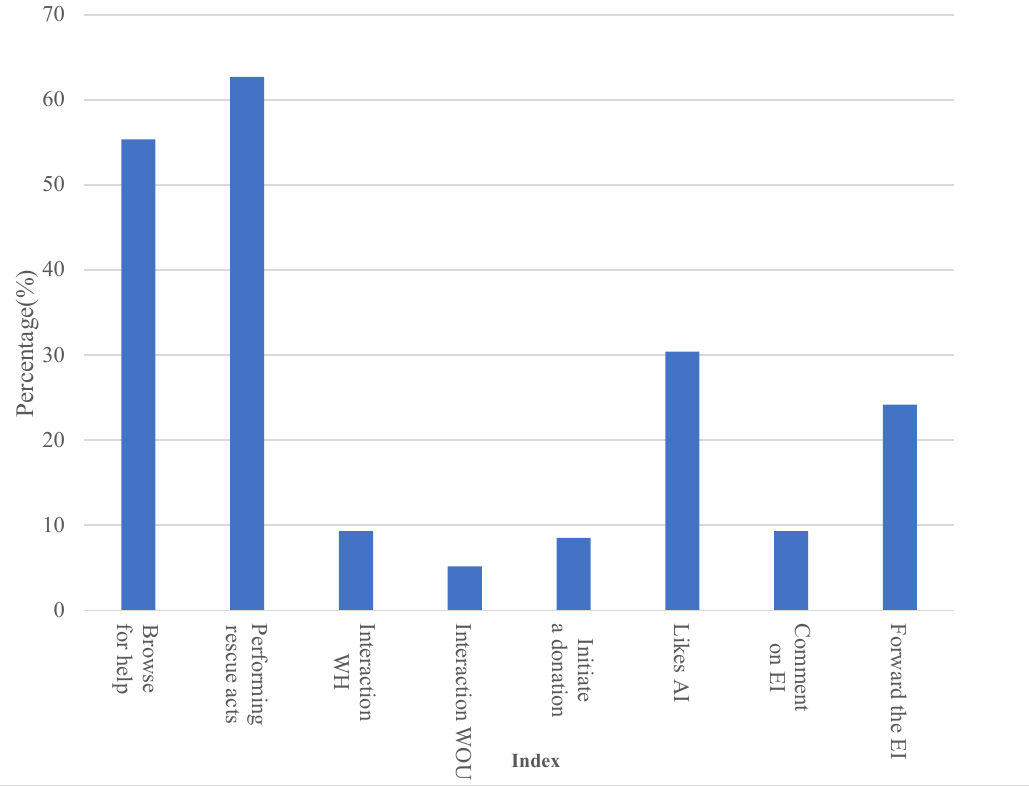
Figure 7. Statistical information on the use of the platform. Figure 8. Statistical information on the use of the platform. The satisfaction of users of the public welfare platform is shown in Table 3. The P Table 3. Path value is the correlation coefficient. P < 0.005 indicates that the indicators are positively correlated. It can be seen that user satisfaction was above 0.75. Table 3. Path factor.